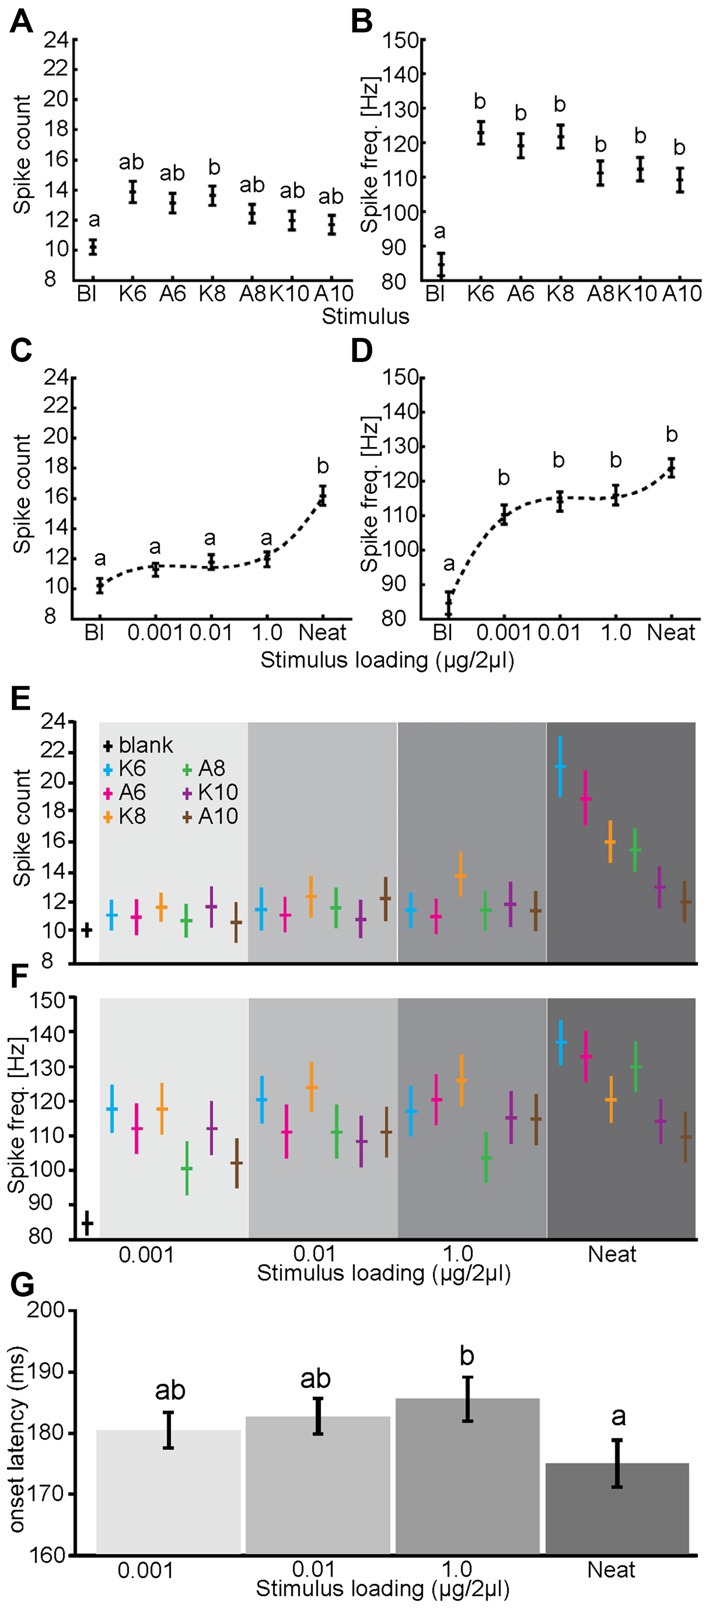
Massed activity provides odor dependent and limited concentration dependent information. The main effects of odor identity (A,B) and stimulus loading (C,D) on spike counts (A,C) and peak spike frequency (B,D). For this analysis spatial and temporal information are collapsed. By comparison to blank, all odors produced a significantly higher peak spike frequency (B; p < 0.01; Kruskal-Wallis) but not significantly different spike counts (A) though the trend was consistent with frequency. Note that there are no significant between-odor differences in either count or frequency. In response to different concentrations of odor stimulation, neat odor presentation resulted in a significantly greater overall spike count (C; p < 0.01) but not peak spike frequency. Conversely, blank stimuli resulted in significantly lower peak spike frequency than did odor at any stimulus loading (D; p < 0.01). (E,F) The two-way interactions of odor and stimulus loading on spike counts and peak spike frequency. Note in both measures that neat odor did produce some odor dependent effects, these appear to relate to odor volatility. (G) Mean response onset latency relative to stimulus onset (in ms) as a function of stimulus loading (blank responses dropped). Inset letters indicate statistical differences in latency (one-tailed paired t-test; p < 0.05). In all panels, error bars represent standard error.